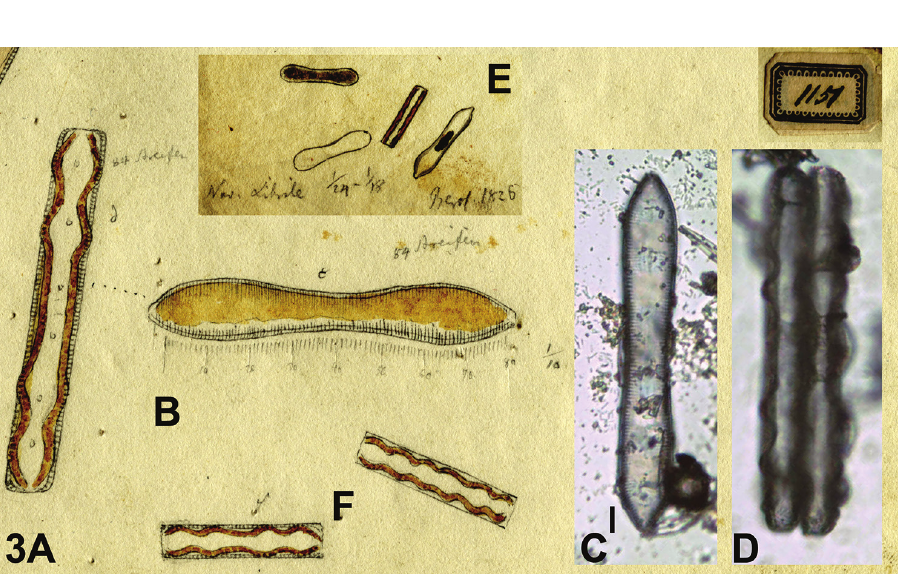
Figure 3. Surirella librile . Lectotype: Drawing BHUPM 1151. A Girdle view representing the lectotype (corresponding to preparation BHUPM 540177-3 in 3D) B Valvar view representing the lectotype; Ehrenberg indicated two views of one cell with dots between the undulated girdle view in A and the valvar view in B. C Corresponding preparation BHUPM 540177-4 D Corresponding preparation BHUPM 540177-3 E Documentation of Ehrenberg’s observations in 1826 F Small cells in girdle view not cor- reponding to the published protologue. Scale bar for C–D = 10